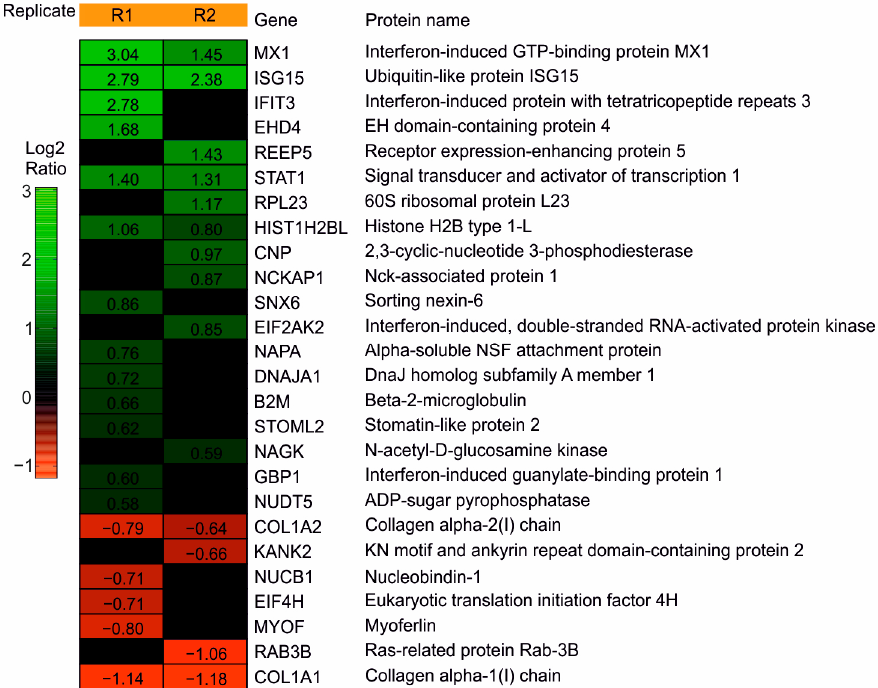
Figure 2. Heatmap of the IRGs regulated in HFFs after the DB incubation. HFFs were exposed to TR- ∆ GFP-derived DBs. IRG levels were compared to the levels of the mock cells at 24 h.p.a. The samples were measured on a Q Exactive Plus mass spectrometer. Heatmap of the 26 IRGs that were found to be differentially regulated in HFFs, exposed to 10 µ g of DBs. The expression patterns of the proteins were arranged hierarchically, based on the log2 converted normalized ratio of two technical replicates (R1; R2). The log2ratio is represented by a color gradient. Nineteen up-regulated (green) and seven down-regulated (red) IRGs with a fold-change of at least 1.5 (log2ratio ± 0.58) in one of the technical replicates, were considered to be differentially regulated. Black areas represent the values that did not reach the threshold of ±0.58.